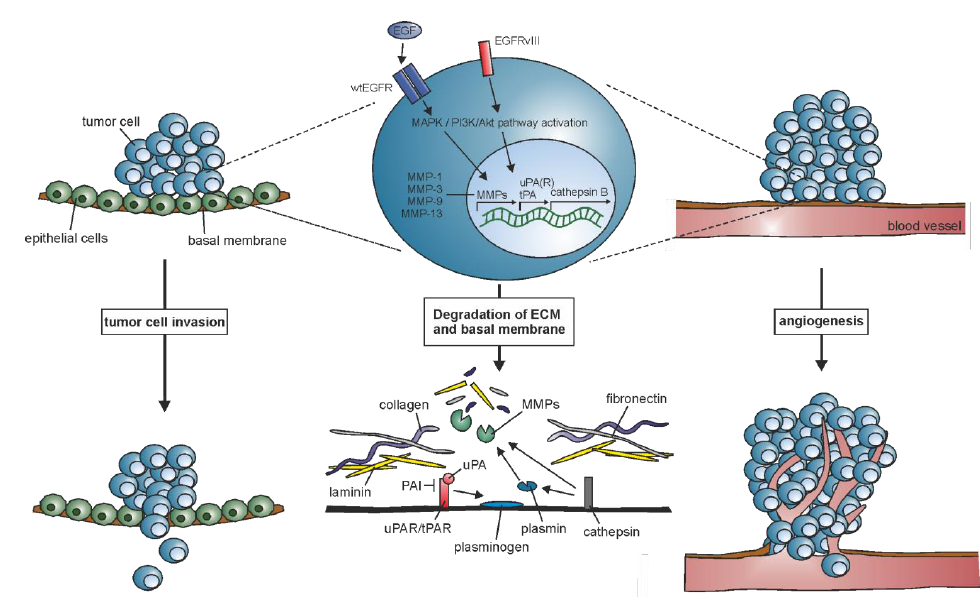
Figure 1. EGFR and EGFRvIII contribute to the upregulation of the extracellular matrix (ECM)- degrading proteases matrix metalloproteases (MMPs), urokinase-type plasminogen activator (uPA), tissue-type plasminogen activator (tPA), and cathepsin B, which leads to degradation of